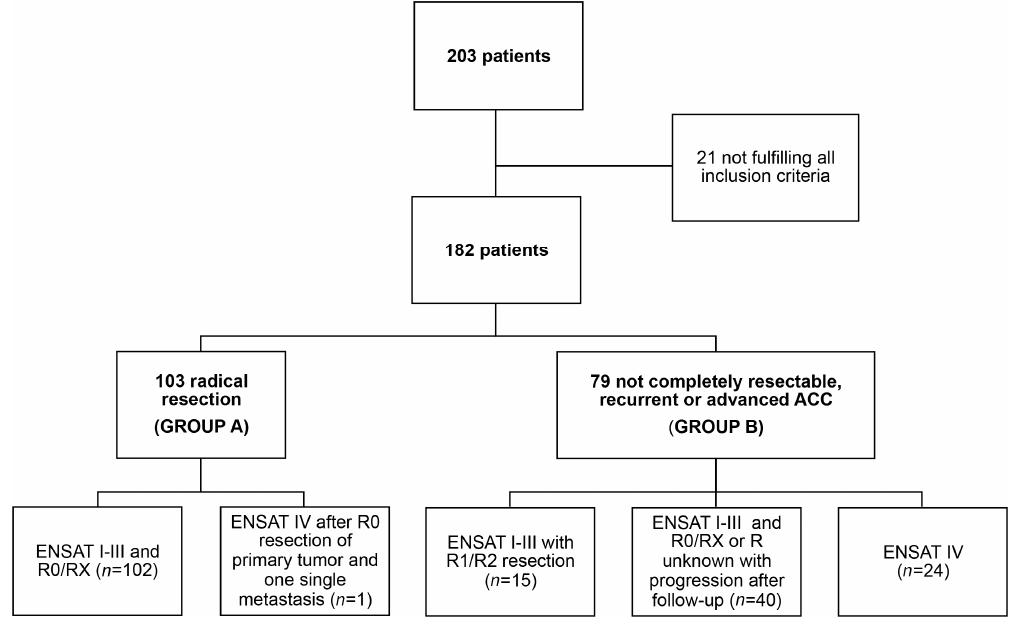
Figure 1. Flowchart of patients with adrenocortical carcinoma included in the present study.